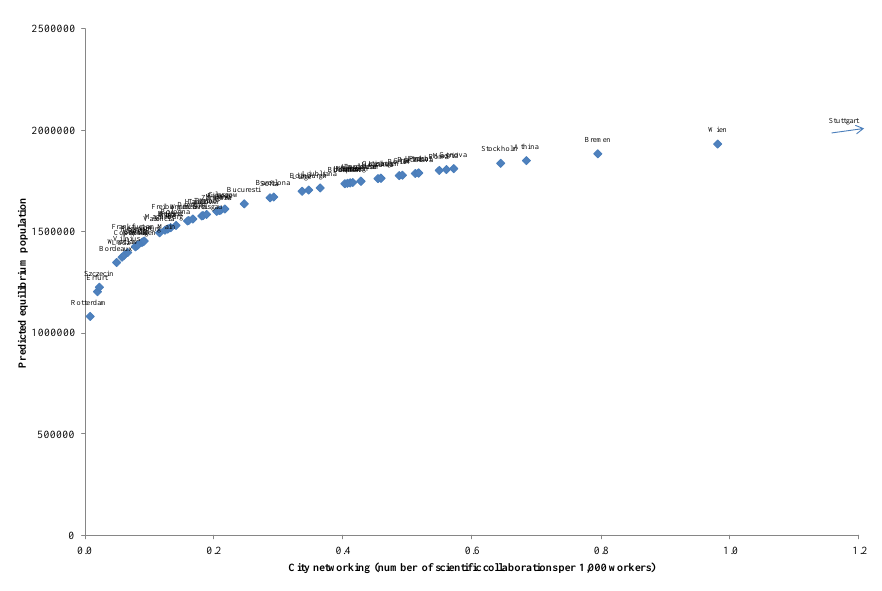
Figure 3 : Equilibrium City Size for Different Degrees of Urban Networking